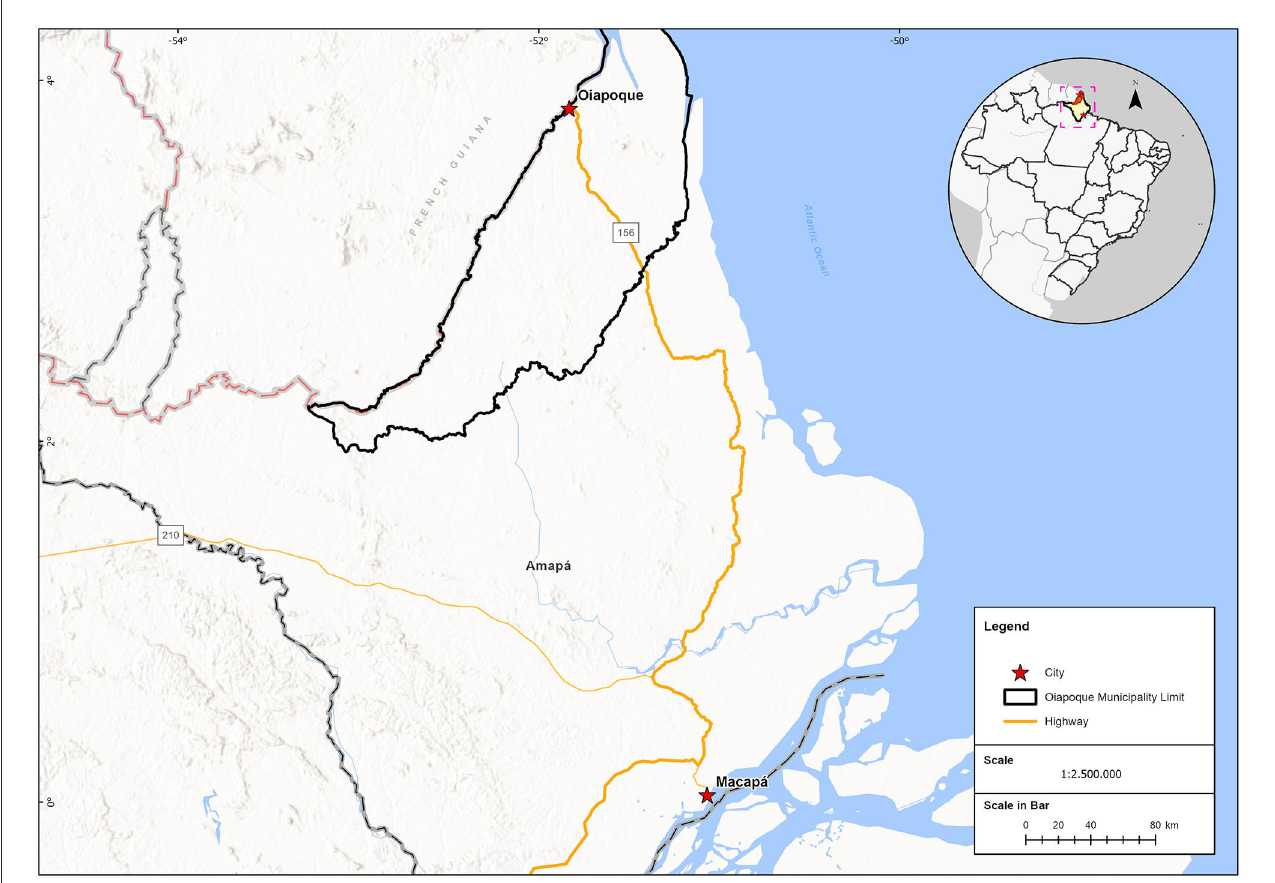
FIGURE1 Location of the state of Amapa Brazil, and the municipality of Oiapoque. Border with the French territory, French Guyana.